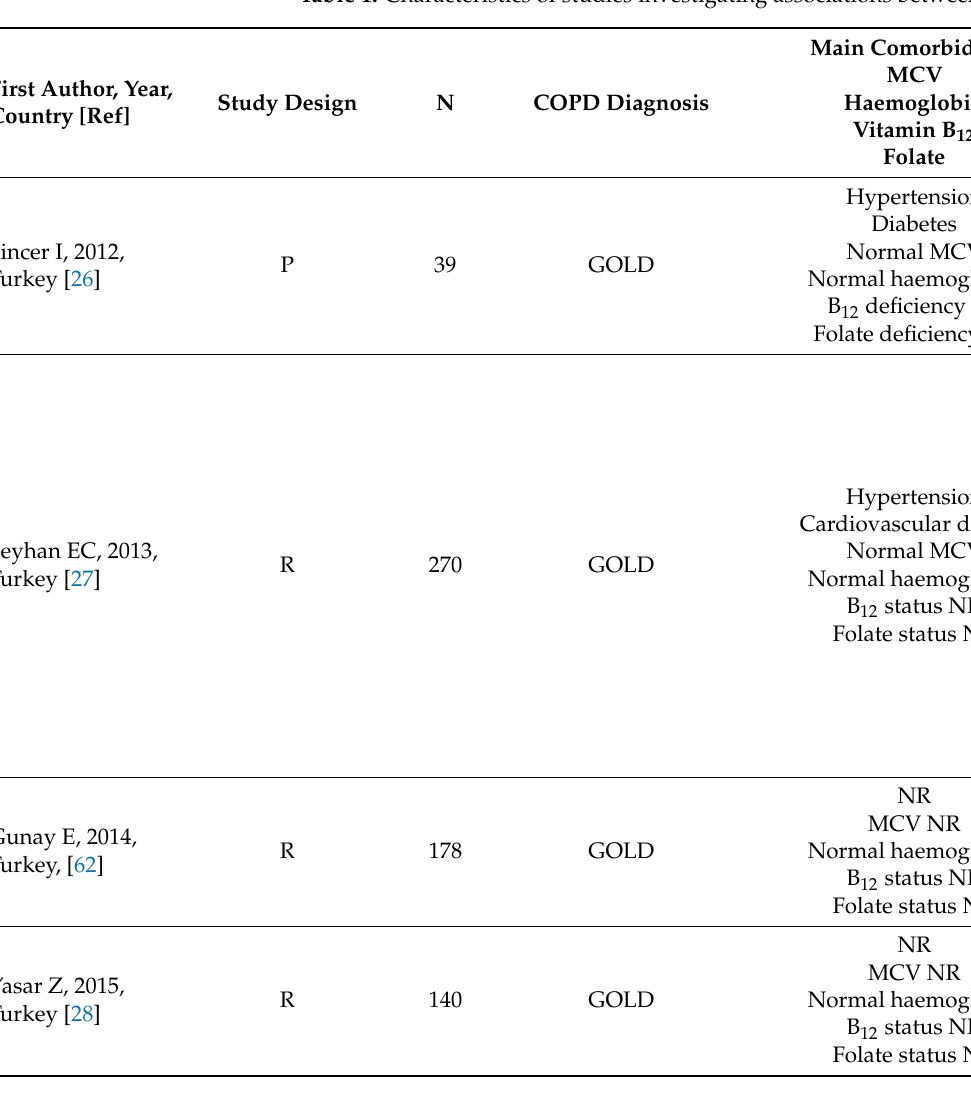
Table 1. Characteristics of studies investigating associations between RDW and clinical endpoints in patients with stable